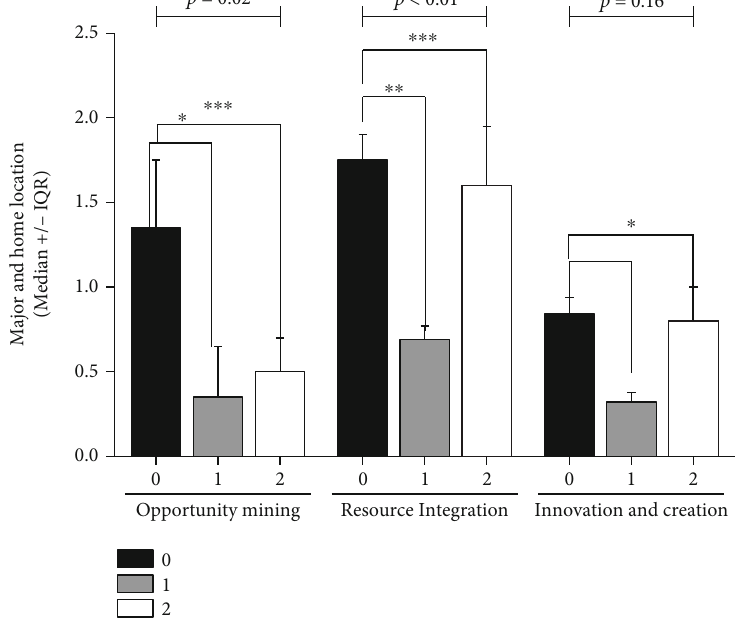
Figure 5: Descriptive analysis of entrepreneurial competencies in general and in each